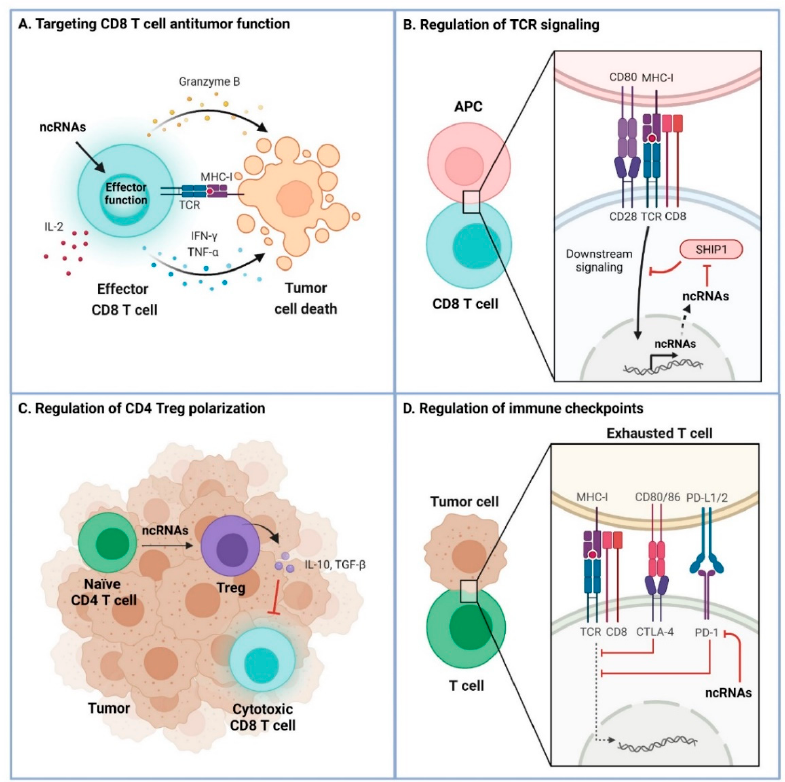
Figure 2. Molecular regulatory mechanisms of ncRNA in tumor immunology. ( A ) Targeting CD8 T cell antitumor function. CD8 T cells recognize tumor cells and exert cytotoxic functions upon engagement of the T cell receptor (TCR) and the antigen-derived peptide loaded on major histo- compatibility type I molecules (MHC-I) on tumor cells. NcRNAs regulate the antitumor function of CD8 T cells, characterized by secretion of IL-2, IFN- γ , TFN- α and granzyme B. ( B ) Regulation of TCR signaling. Downstream signaling induced upon TCR engagement promotes the expression of ncRNAs. NcRNAs can control TCR signaling by targeting phosphatase SHIP1, a negative regulator of TCR signaling, thereby increasing TCR signaling. ( C ) Regulation of CD4 Treg polarization.